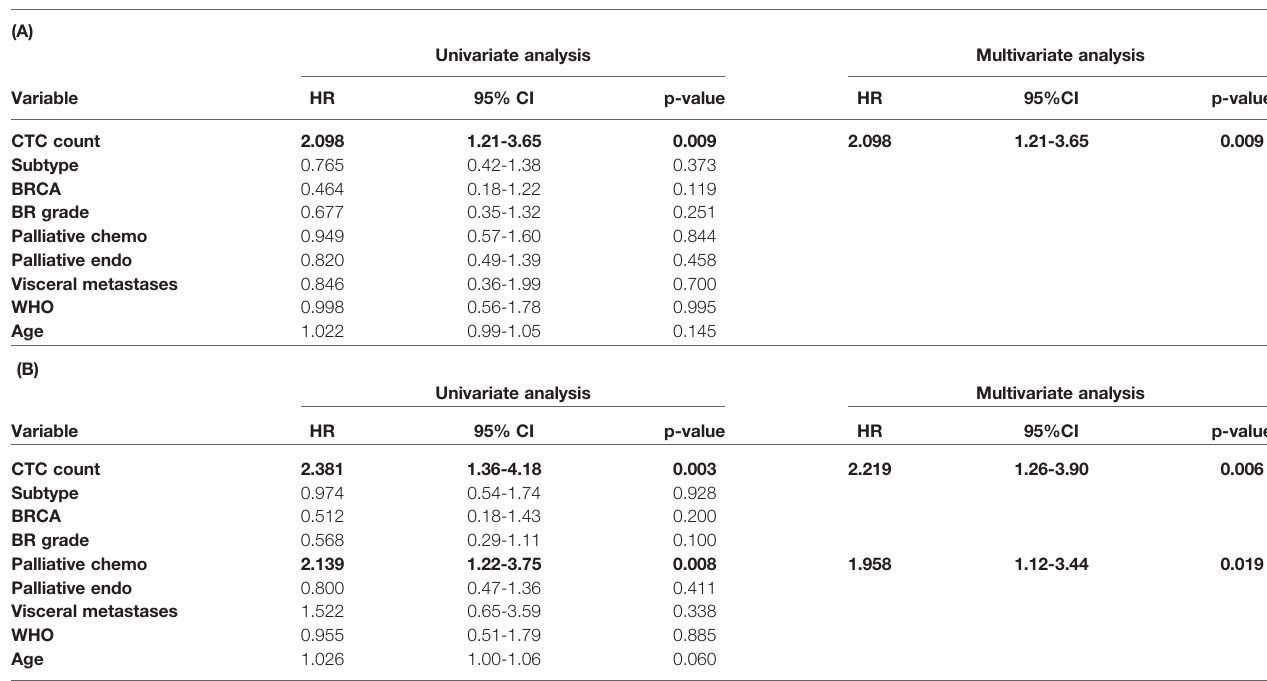
TABLE 2 | Univariate and multivariate Cox Regression